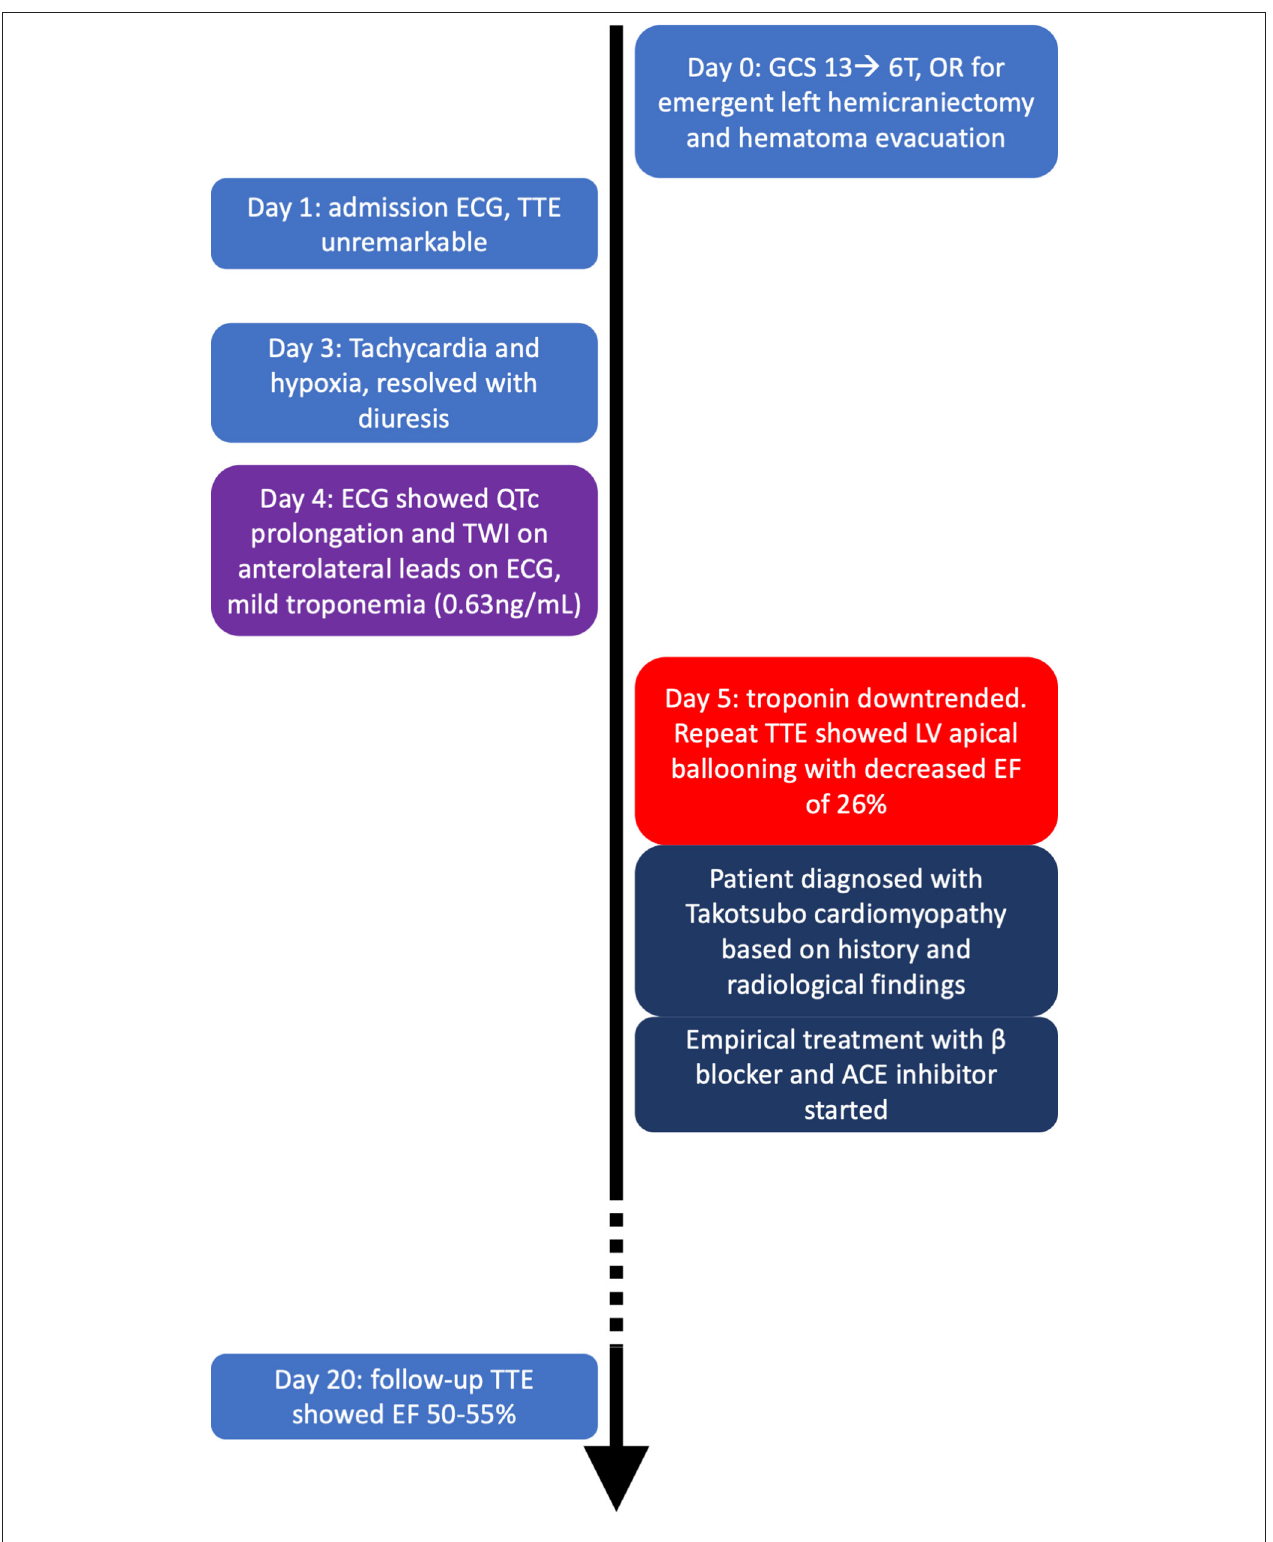
FIGURE 1 | Timeline of presentation and outcome in this